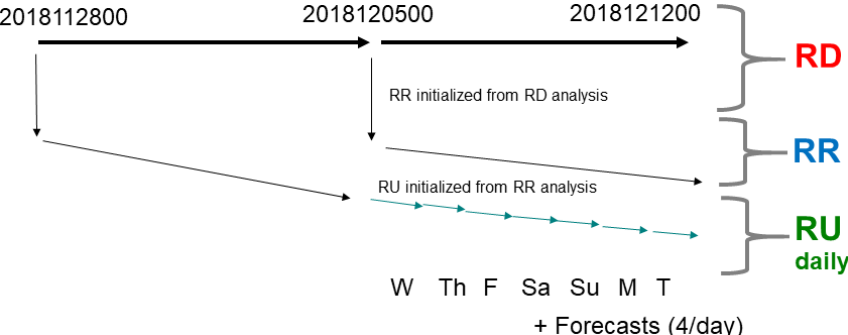
Figure 2. Schematic diagram showing the sequencing of the delayed-mode (RD), real-time (RR), and daily update cycles (RU). The RD cycle is run 7d behind real time each Wednesday and provides continuity in time. The RR cycle is initialized from the RD cycle and provides a real-time analysis each Wednesday. Finally, the RU cycles provide daily updates using a shorter 1d analysis cycle assimilating only sea ice and sea surface temperature. Additionally, 48h forecasts are produced from RU analyses four times per day (00:00, 06:00, 12:00,